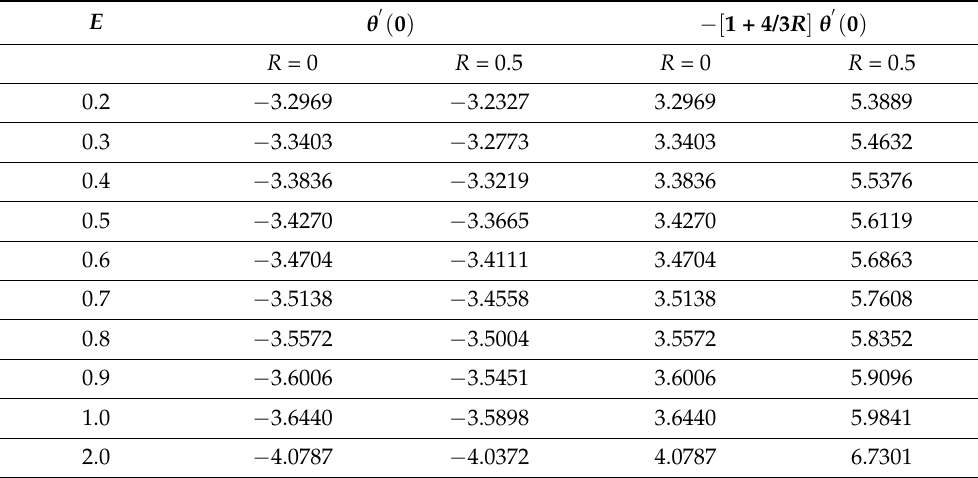
Table 12. Impact of Eckert number on Nusselt number for radiative and non-radiative flow